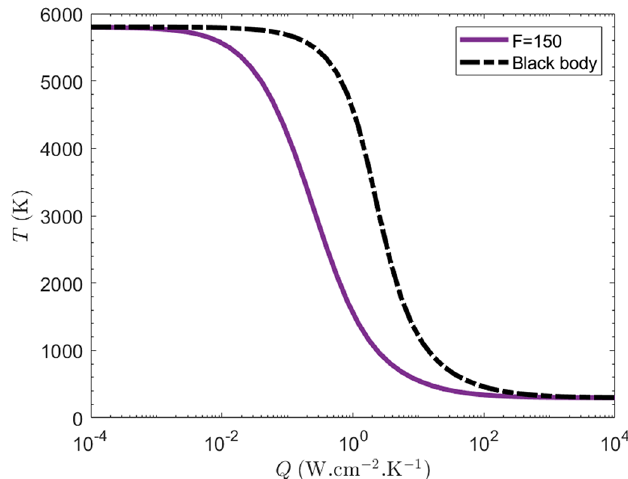
Fig. 5. Comparison of the evolution of the temperature in open circuit with the thermalization coef fi cient Q in a black body and in the case F =150.